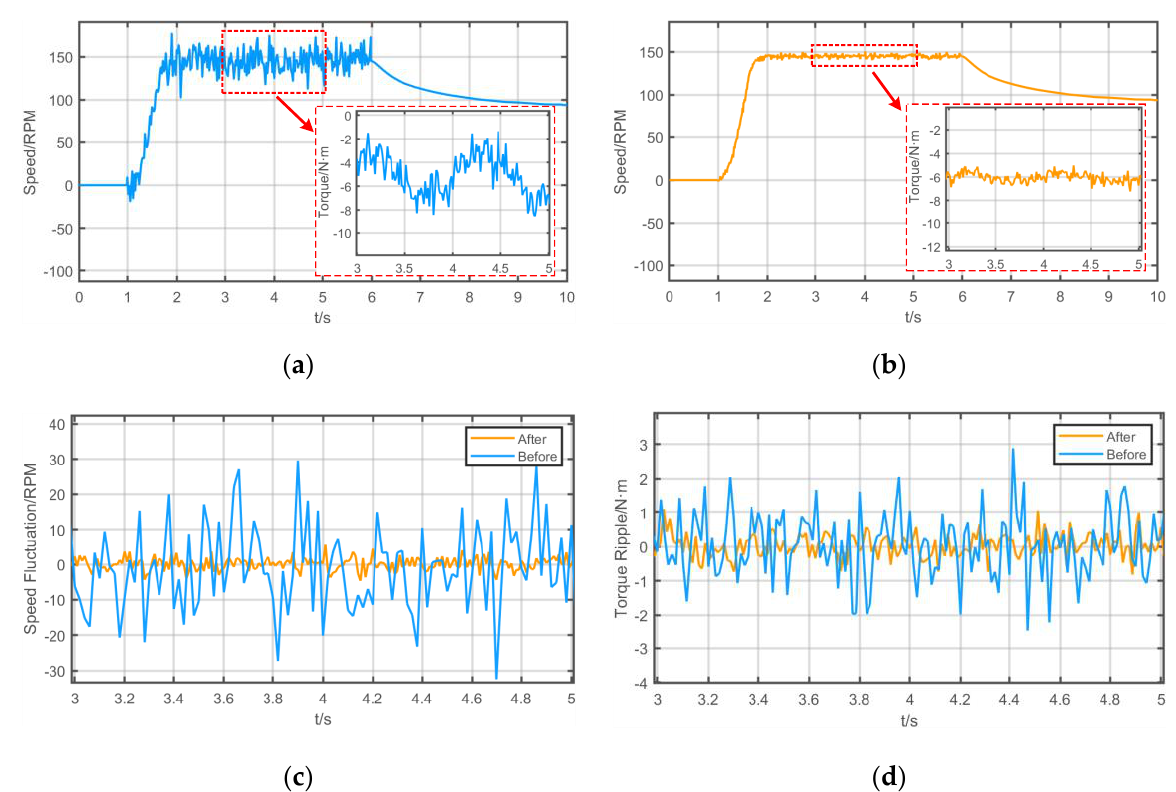
Figure 7. The simulation results. ( a ) The speed curve and load torque waveform of the loading motor before the application of this method. ( b ) The speed curve and load torque waveform of the loading motor after the application of this method. ( c ) The speed fluctuation of the loading motor at a steady state from t = 3 s to t = 5 s, before and after the application of this method. ( d ) The torque ripple of the loading motor at a steady state from t = 3 s to t = 5 s, before and after the application of this method.